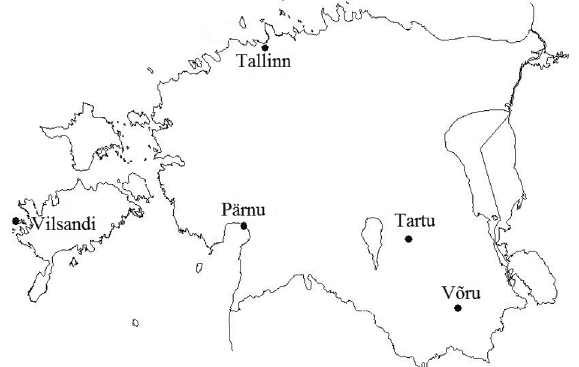
Fig. 2. Location of the five meteorological stations discussed in the